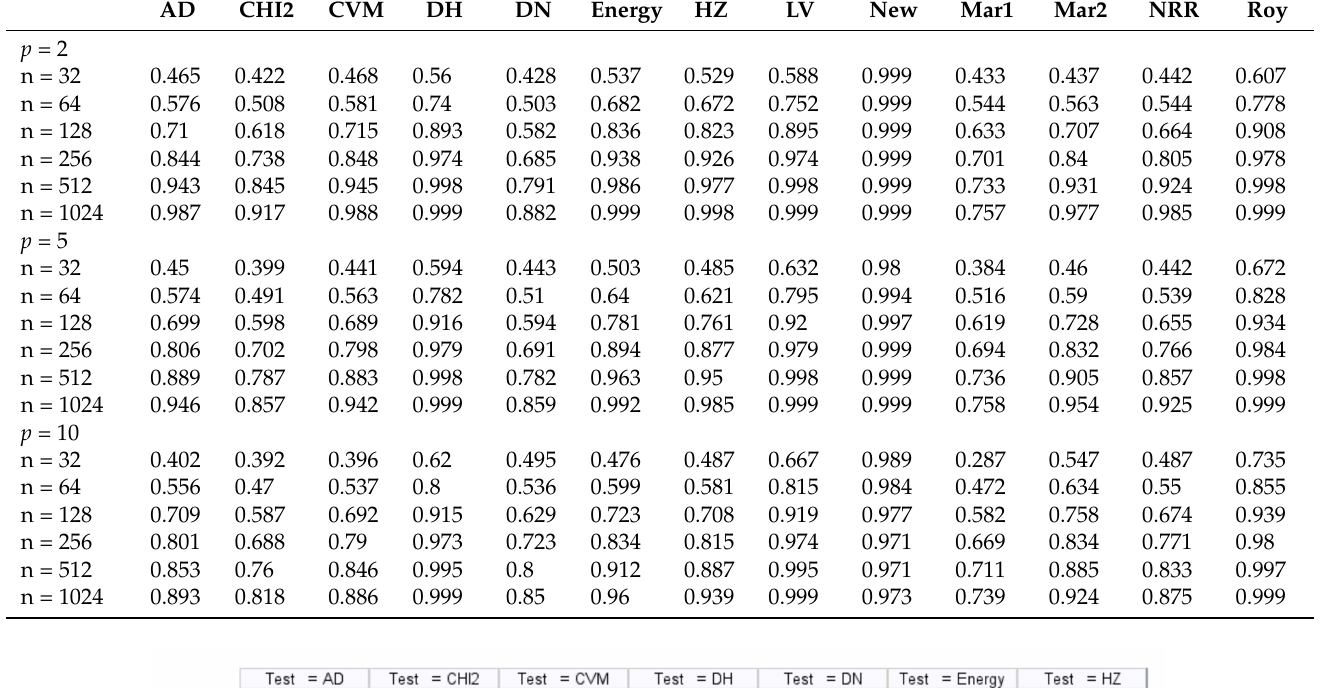
Table 5. An average empirical power for a group of normal mixture distributions.